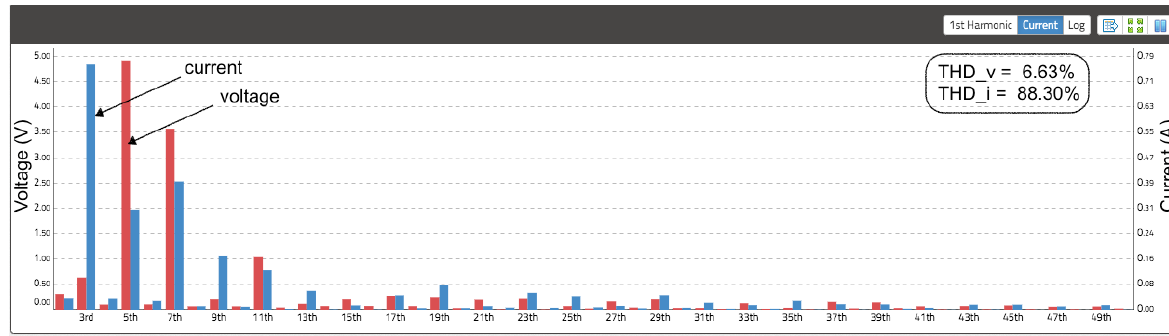
Figure 4. Voltage and current spectrum of the waveforms in Figure